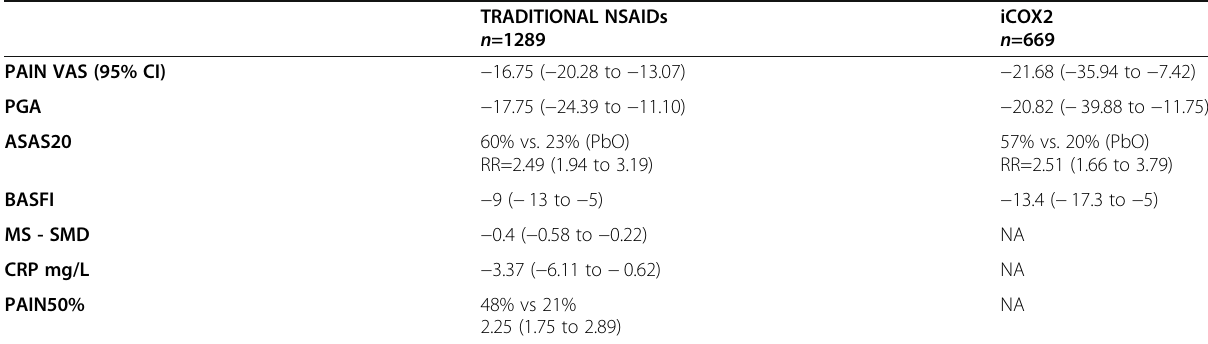
protein, PAIN50% ≥ 50% improvement in pain, RR relative risk, PbO placebo, N/A meta-analysis not